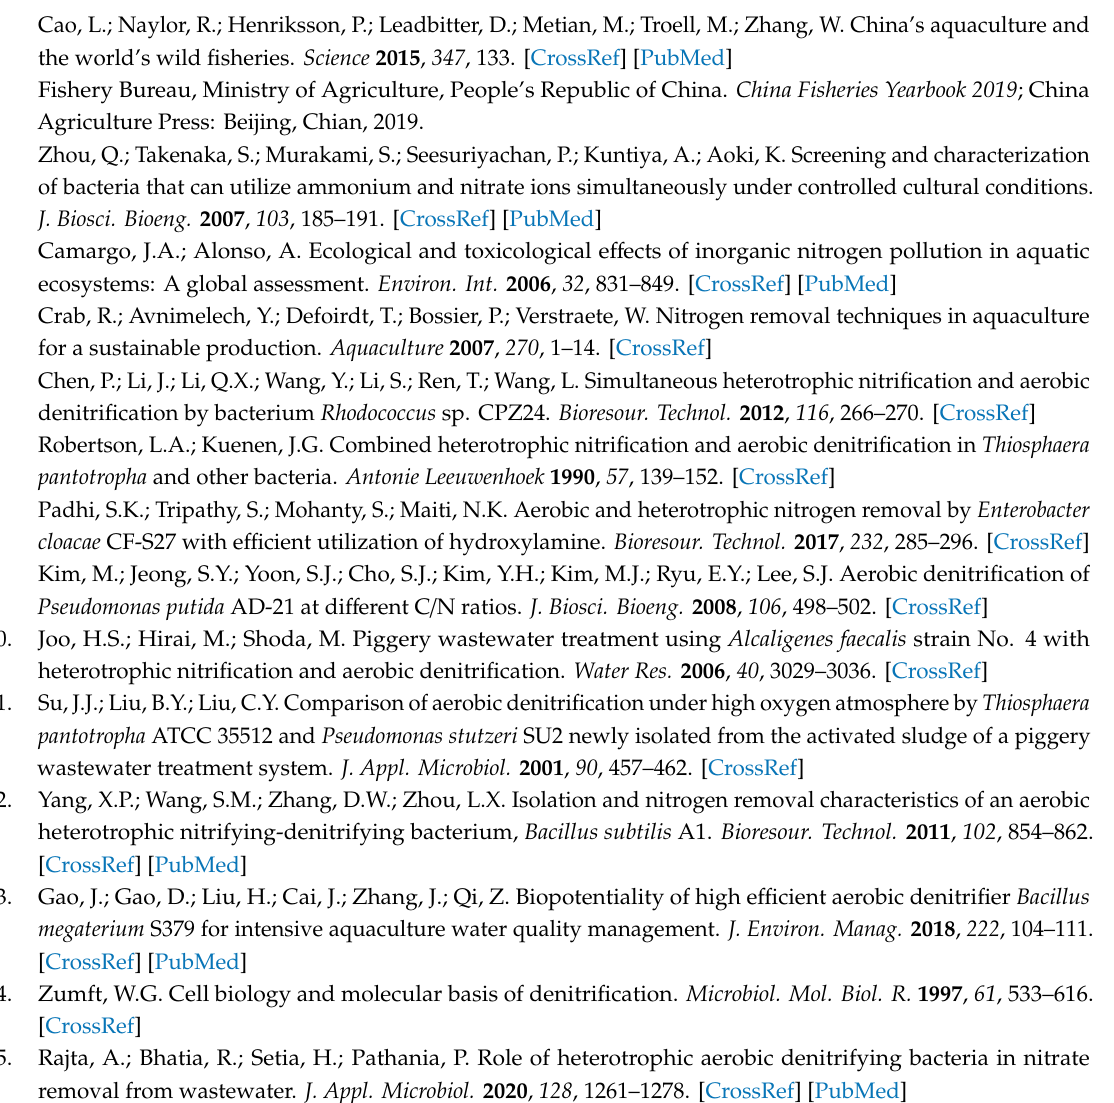
Table S1. The related primers for corresponding genes. Figure S1. The agarose gel electrophoresis of the qRT-PCR amplification product of nirK gene (lane 1) and 16S rRNA gene (lane 2) from strain SC16. Figure S2. E ff ects of carbon source ( a ), C / N ratio ( b ), pH ( c ) and temperature ( d ) on the growth and nitrogen removal of strain SC16 under 60 h